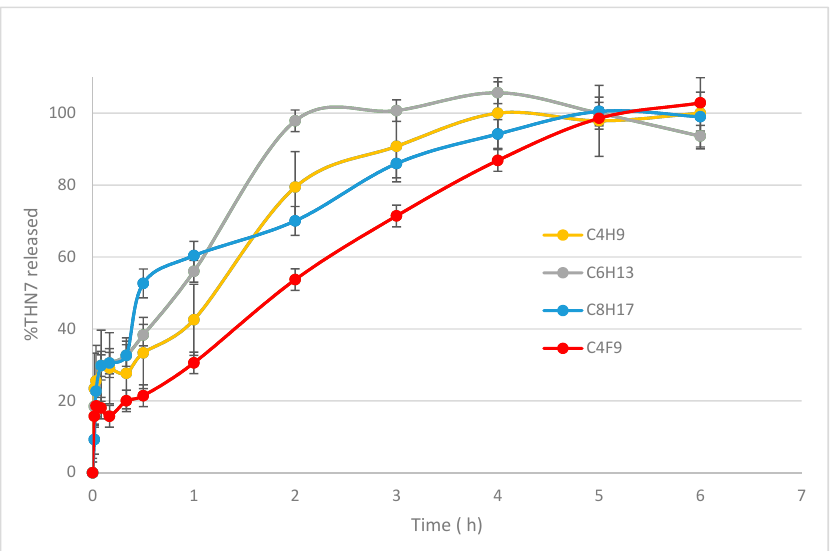
Figure 3. Release profiles of THN7 from loaded nanospheres. The data are the average of three experiments and the error bars indicate the three experiments.